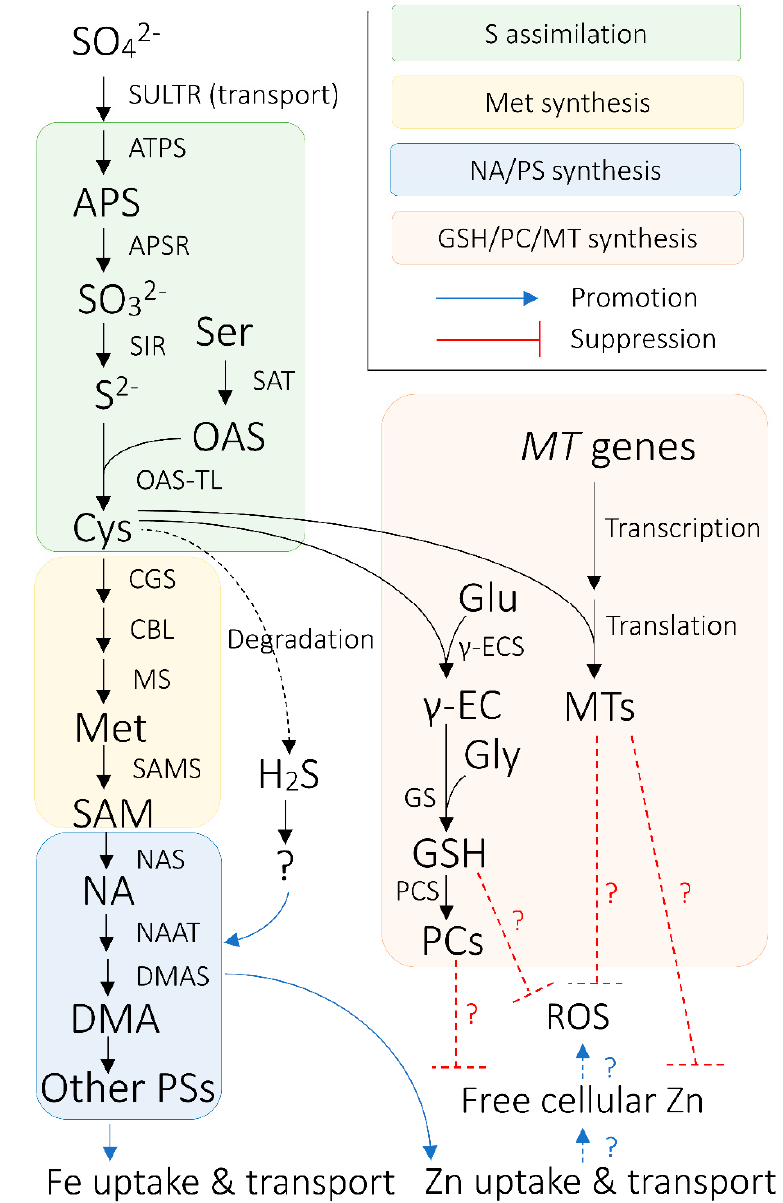
Figure 1. Overview of the connection between sulfur (S) nutrition and iron (Fe) nutrition in cereals plants. Black arrows indicate enzymatic synthetic reactions, unless otherwise indicated. Blue arrows signify promotional effects between biological processes, whereas red bars with flat ends indicate suppressive effects between biological agents and processes. Arrows and bars with dotted lines indicate relationships between biological processes/agents that are hypothetically pronounced in Fe-biofortified crops. Hydrogen sulfide (H 2 S) is hypothesized to regulate nicotianamine (NA)/phytosiderophores (PS) synthesis via unknown biological mechanisms or agents. Abbreviations